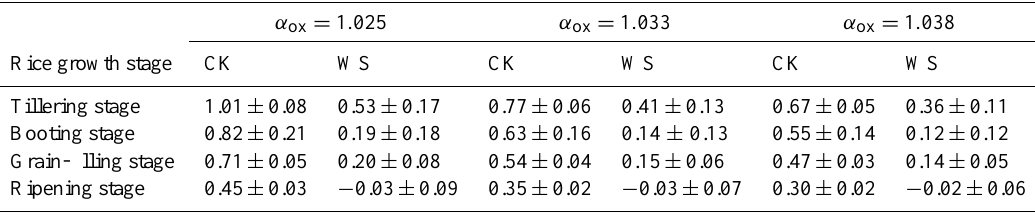
Table 8. Fraction of CH 4 oxidized ( F ox ) a in paddy fields at the four rice growth stages; mean ± SD, n = 3. WS: straw incorporation, CK: without straw incorporation. α ox = 1 .